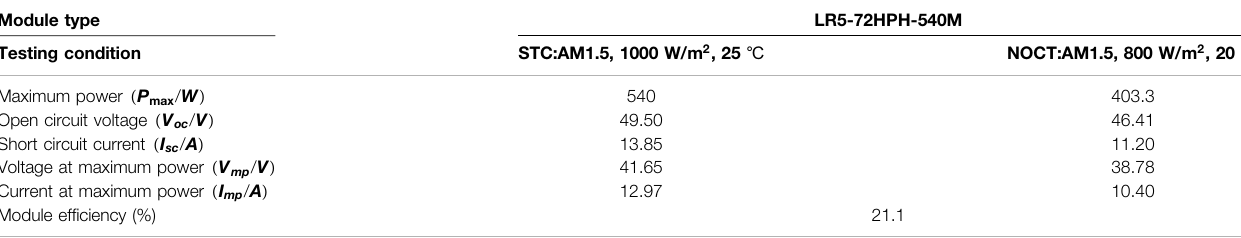
TABLE 2 | Electrical characteristics of LONGI Solar 540W module.